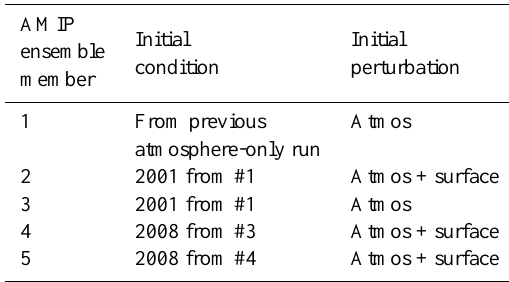
Table 5. Initial perturbation date and technique for the HadGEM2- ES AMIP ensemble